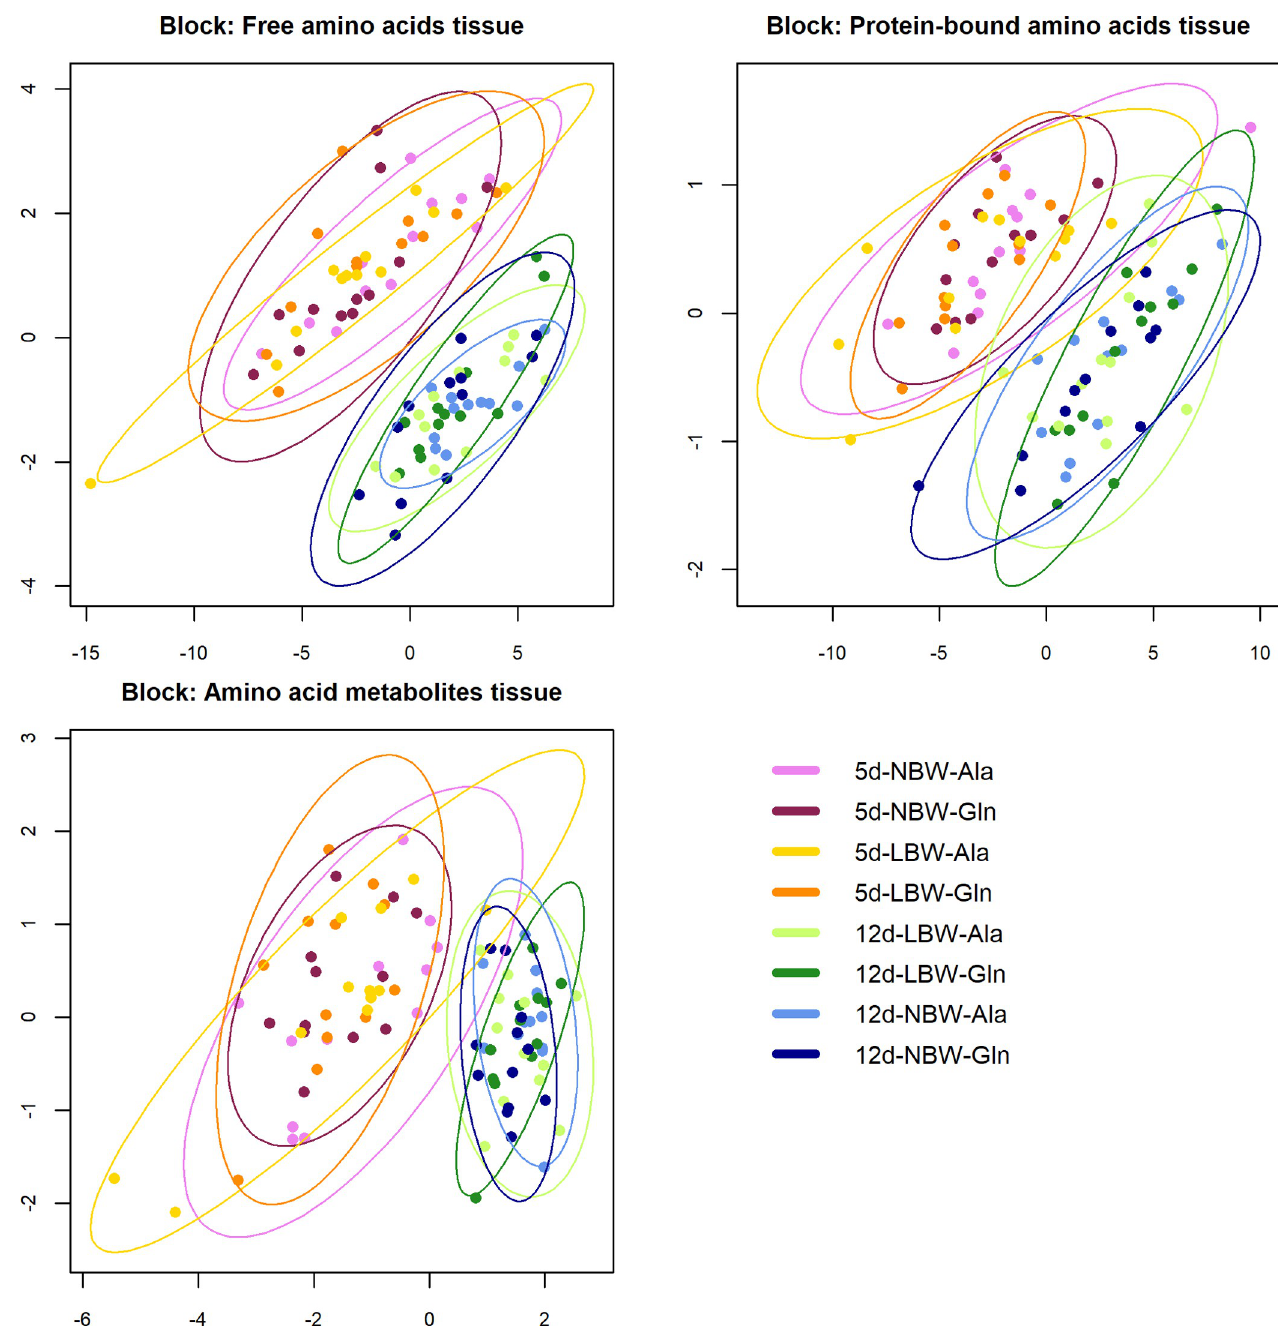
Fig 2. Partial Least-Squares Discriminant Analysis (PLS-DA). Sample plots of the block PLS-DA of all 143 jejunal variables assigned to ten variable groups (‘blocks’) and measured in 96 samples. Shown are the sample plots for the three blocks with the best discriminatory ability: Free amino acids tissue, Protein- bound amino acids tissue, Amino acid metabolites tissue. The other seven blocks are shown in the supplementary material (S1 Fig in S1 File). The colours indicate the eight experimental groups of the 3-factorial crossed design (birth weight: LBW/NBW, supplementation: Ala/Gln and age group: 5 d/12 d) and highlight the main comparison of the two age groups (reddish: 5 d; bluegreen: 12 d).